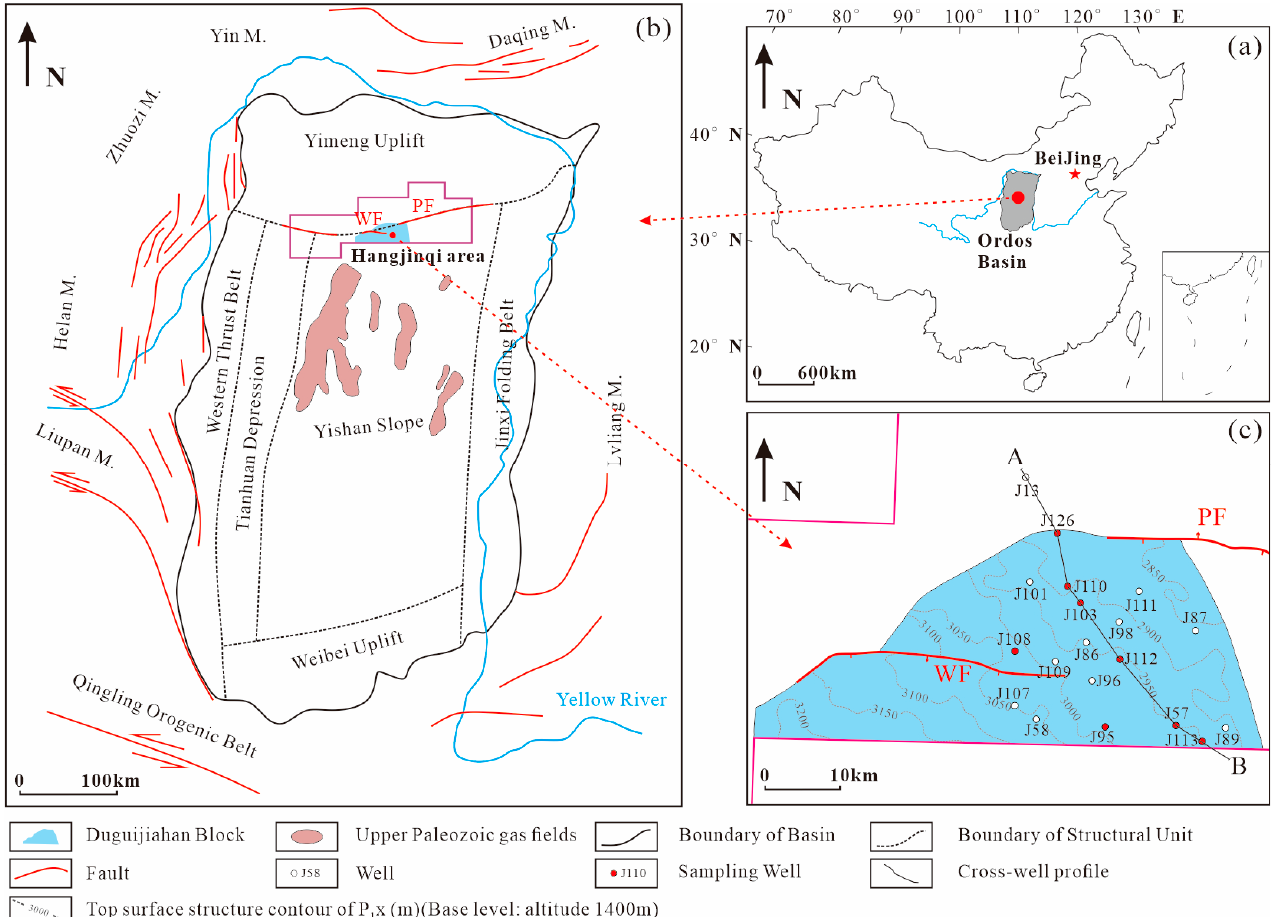
Figure 1. Location of ( a ) the Ordos Basin in China, and ( b ) major tectonic units of the Ordos Basin and the structural position of the Hangjinqi area in the Ordos Basin. The structural position of ( c ) the Duguijiahan block in the Hanjinqi area and location of representative cross-well profile. Abbreviations: SF: Sanyanjing Fault; WF: Wulanjilinmiao Fault; PF: Porjianghaizi Fault (modified after [36,37]).